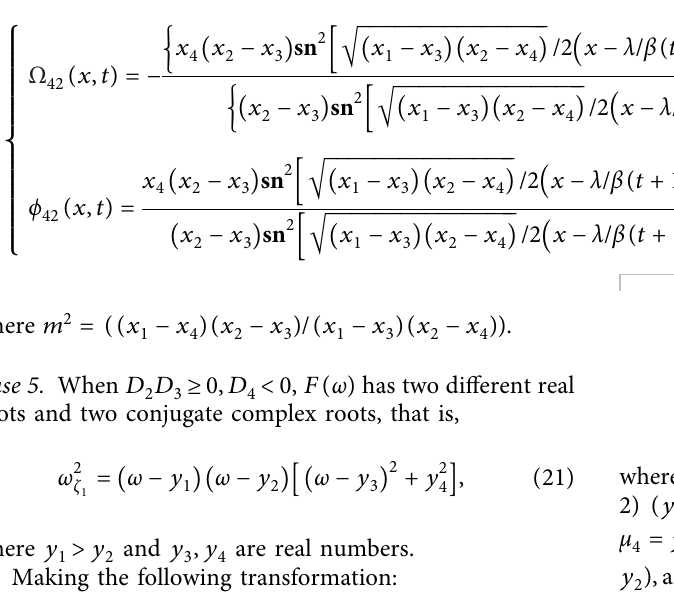
� 3 , a � 0 , λ � 2 ,b � 0 ,and b � ( 3/2 ) (a) 3D surface (b) 2D surface (c) Density 0 1 1 2